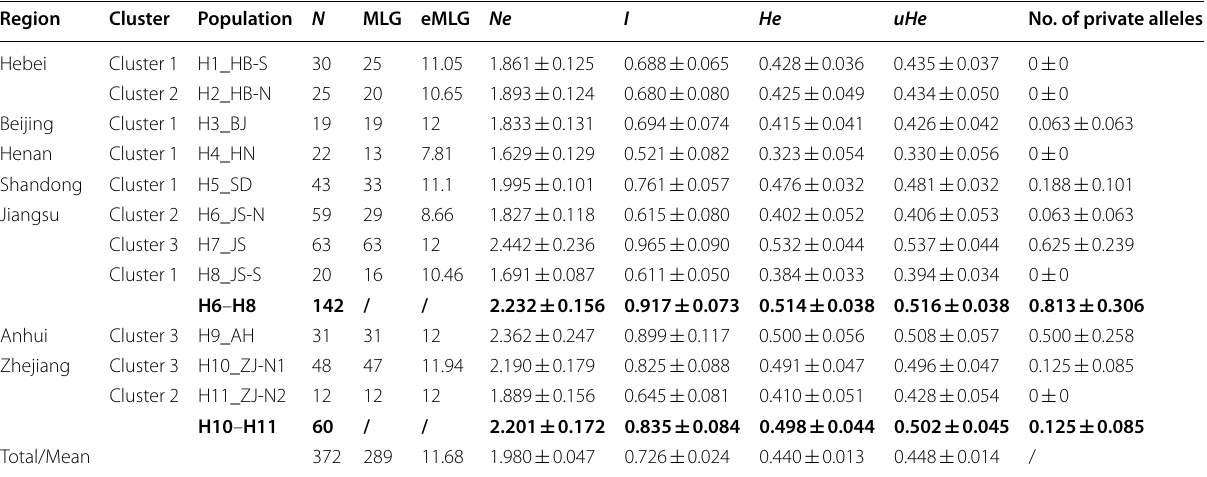
Table 3 Analysis of the genetic diversity of 11 Puccinia triticina populations from 7 regions showed an overall high level of genetic diversity